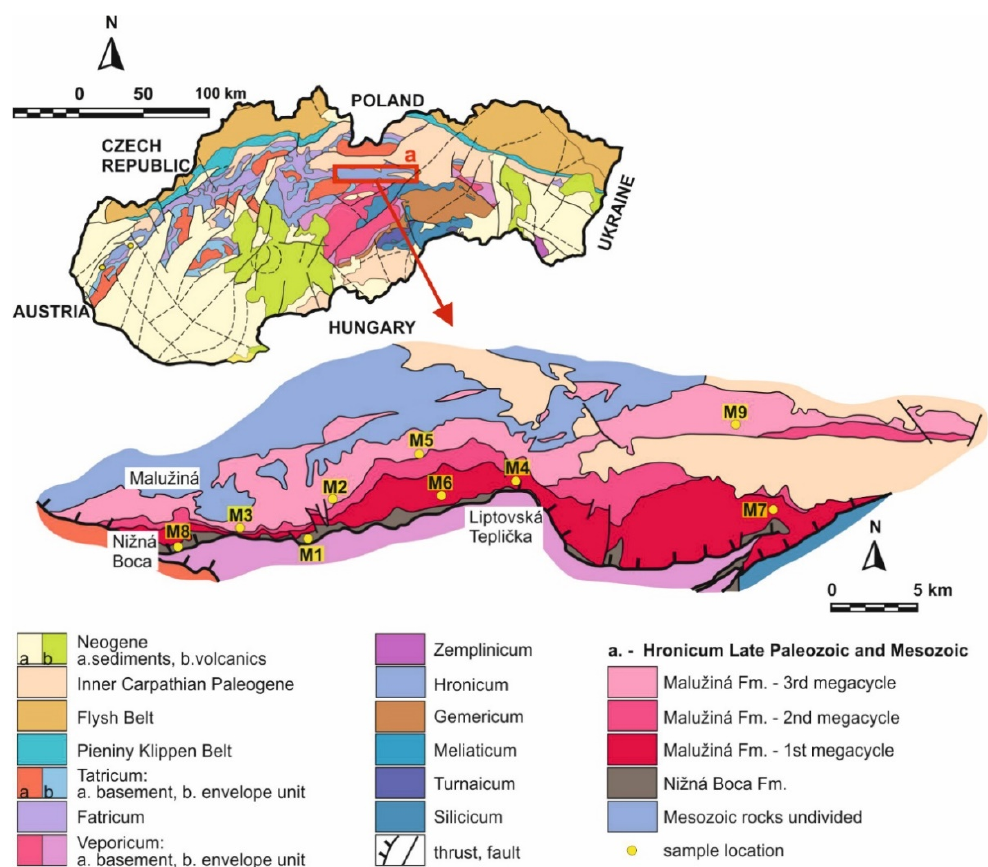
Figure 1. Simplified geological sketch map of the Western Carpathians [15] and schematic geological map of the Hronicum Pennsylvanian–Permian sequence on the northern slopes of the Nízke Tatry Mts. showing sample locations [15].